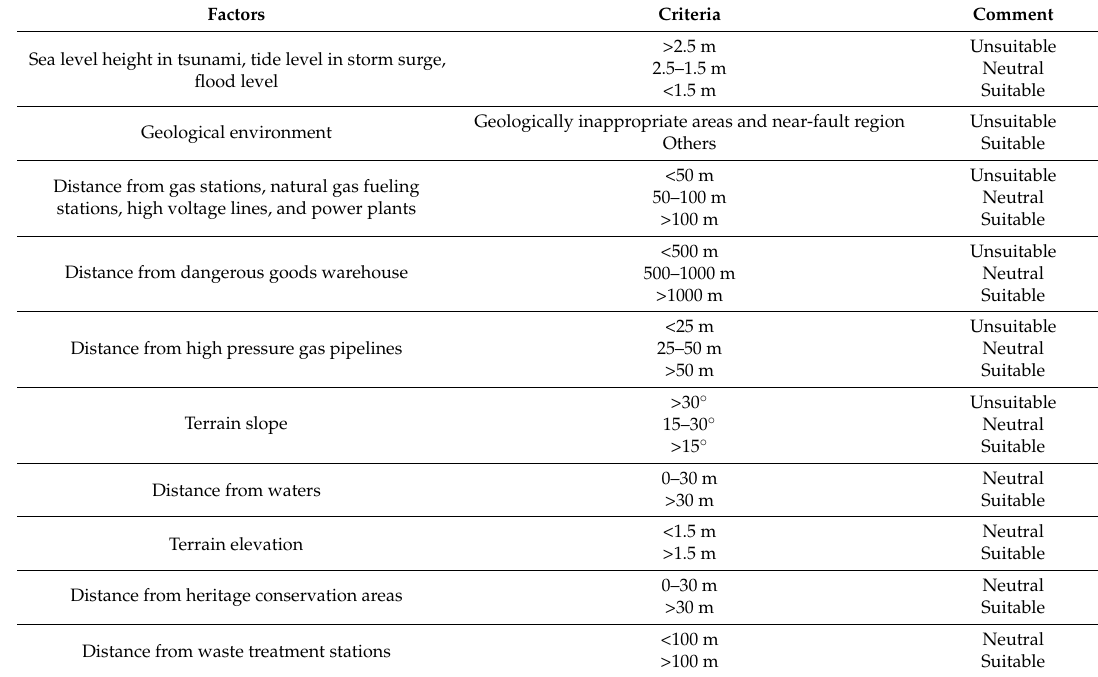
Table 3. Factors in the assessment of urban resources for emergency shelters. Factors